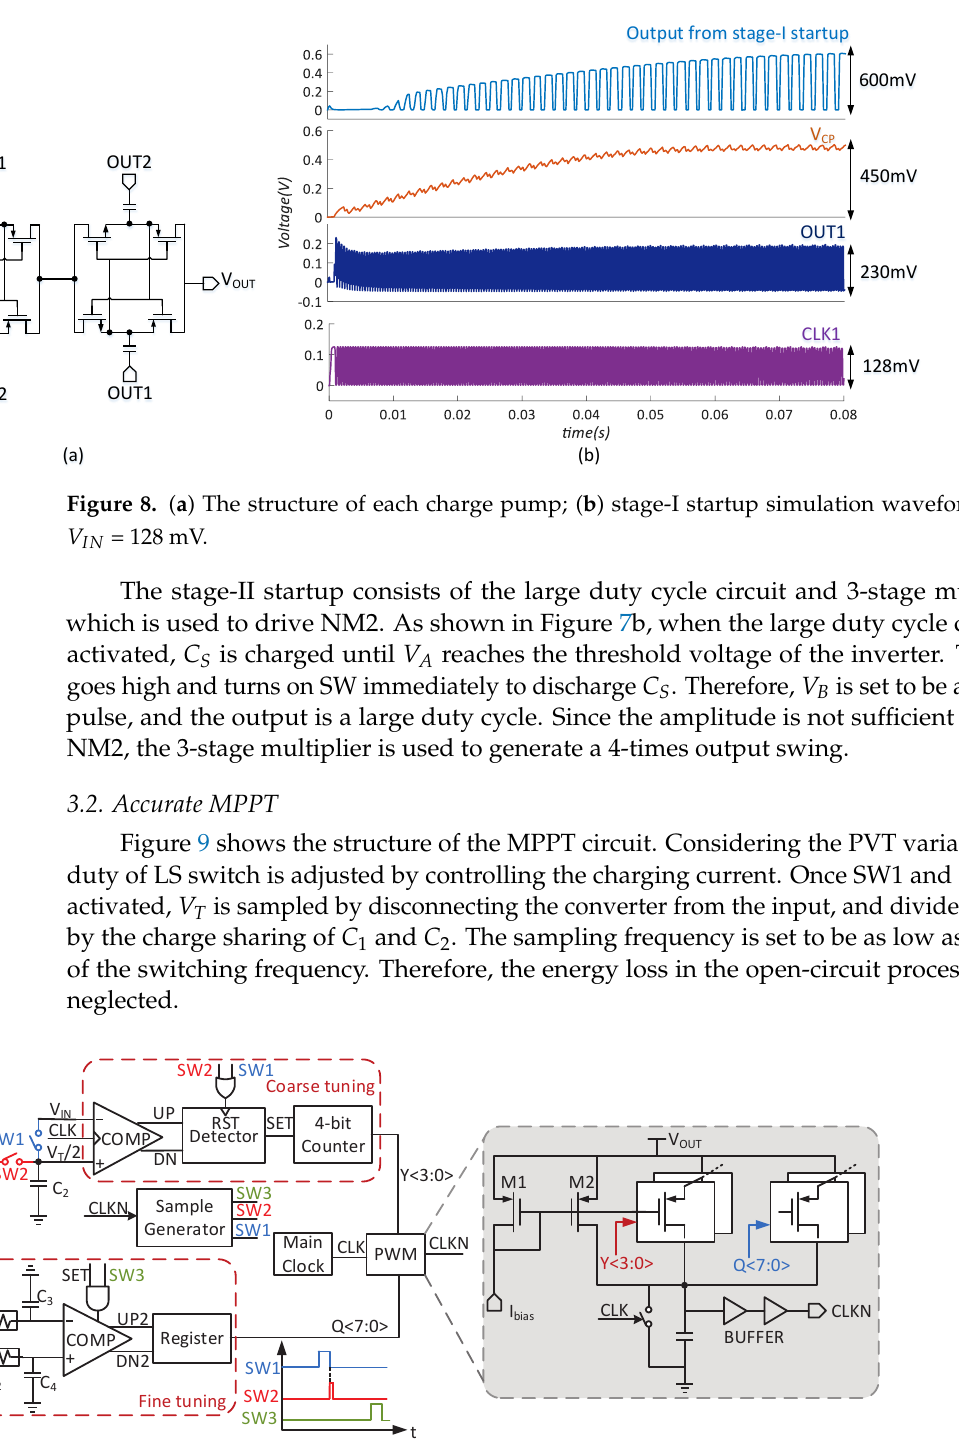
Figure 9. Schematic of the MPPT